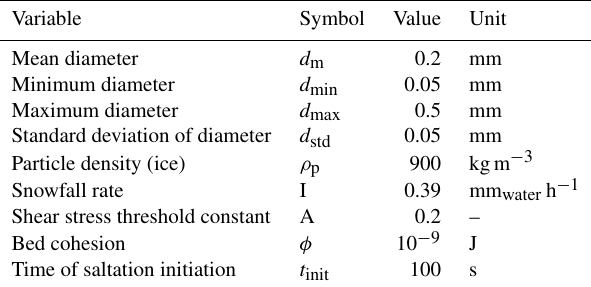
Table 2. Particle properties employed in the sea ice OpenFOAM